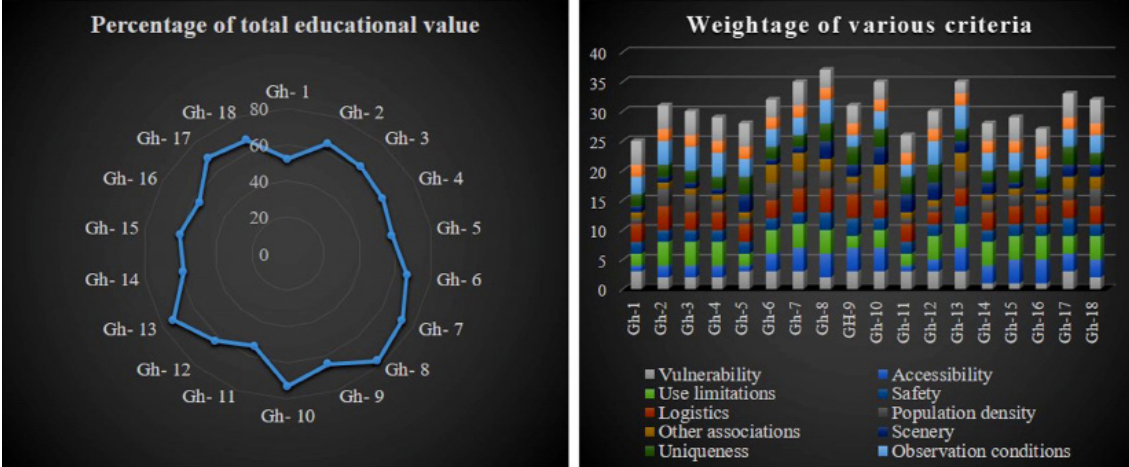
Figure 13. Assessment of the 18 geosites of Kachchh Province, Gh-1 to Gh-18, for educational value. Percentage of educational value (left) and weighting of various criteria of educational value